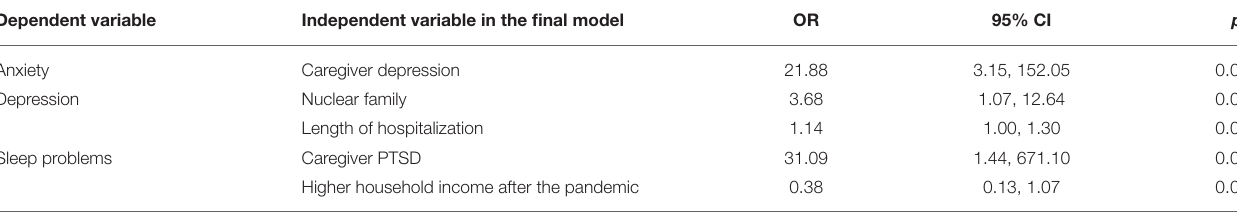
OR, odds ratio; 95% CI, 95% confidence interval. Variables in the logistic regression model for anxiety included gender, age group (13–18 years old), stressful events experienced before the COVID-19 pandemic, social support, and caregivers’ depression. Variables in the logistic regression model for depression included gender, age group (13–18 years old), nuclear family, and length of hospitalization. Variables in the logistic regression model for sleep problems included gender, age group (13–18 years old), higher household income before and after the COVID-19 pandemic, and caregivers’ PTSD. Independent variables in the final model were determined using forward